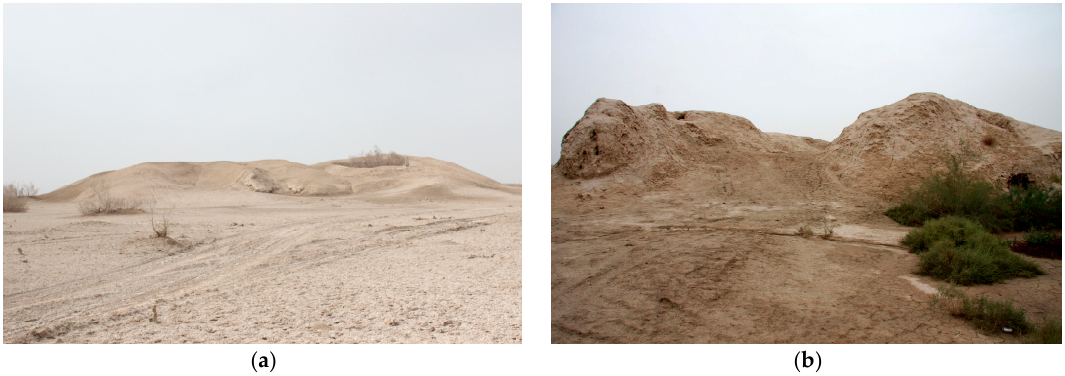
Figure 13. ( a ) The large mount inside the site of Kuyux Shahr city with an 8-meter height; ( b ) the corner of the site Kuhne Shahr in the north-west with a horse-face for defending attack.